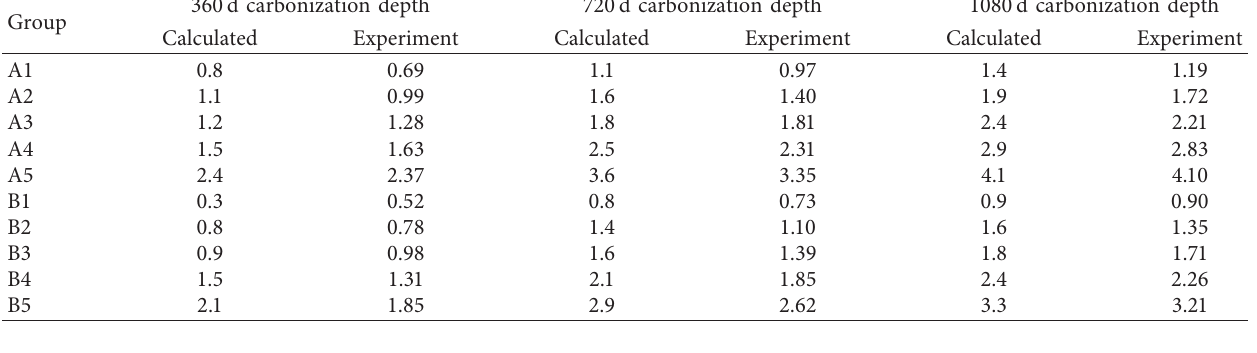
Table 6: Comparison between calculated value of carbonization model and natural carbonation experiment value (mm). Group